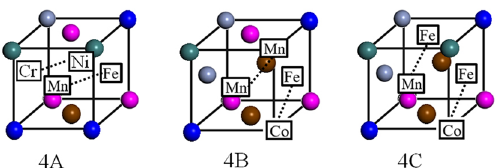
Figure 7. Schematic diagram of tetra-vacancy composed of two di-vacancies with different atomic vacancy formation sequences. The elements enclosed within squares and connected by dotted lines represent the configuration of the di-vacancy cluster formed first.